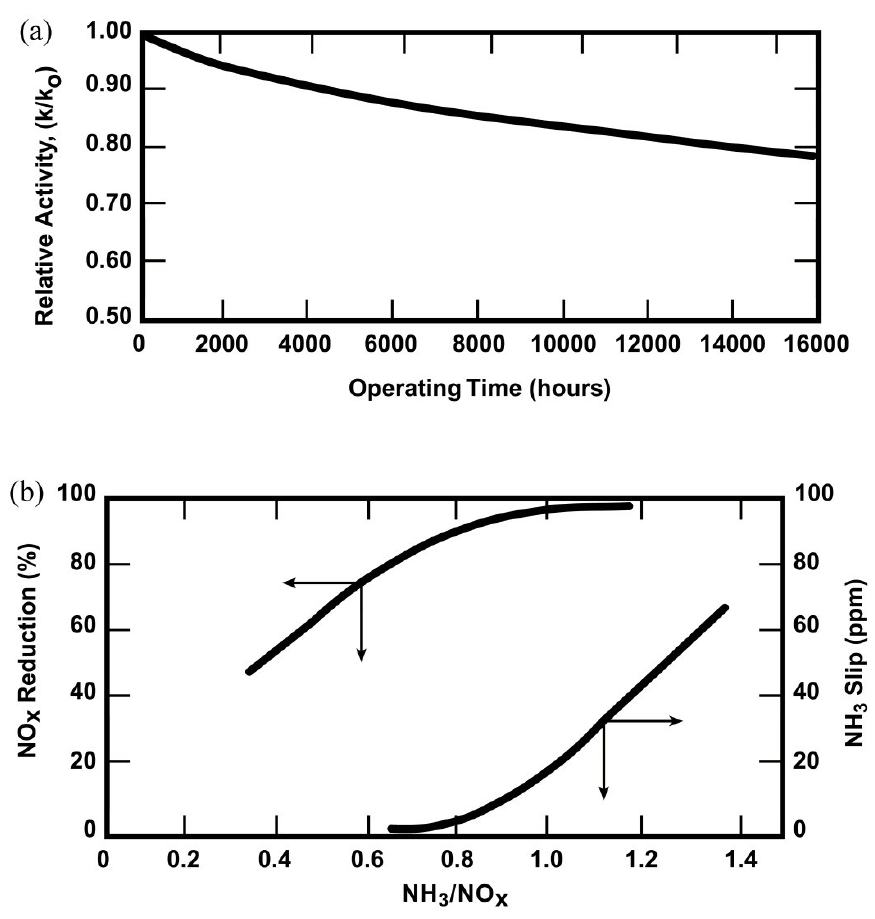
Figure 39. ( a ) Catalyst activity ( k / k o ) vs. time; ( b ) Typical SCR performance. Reproduced from